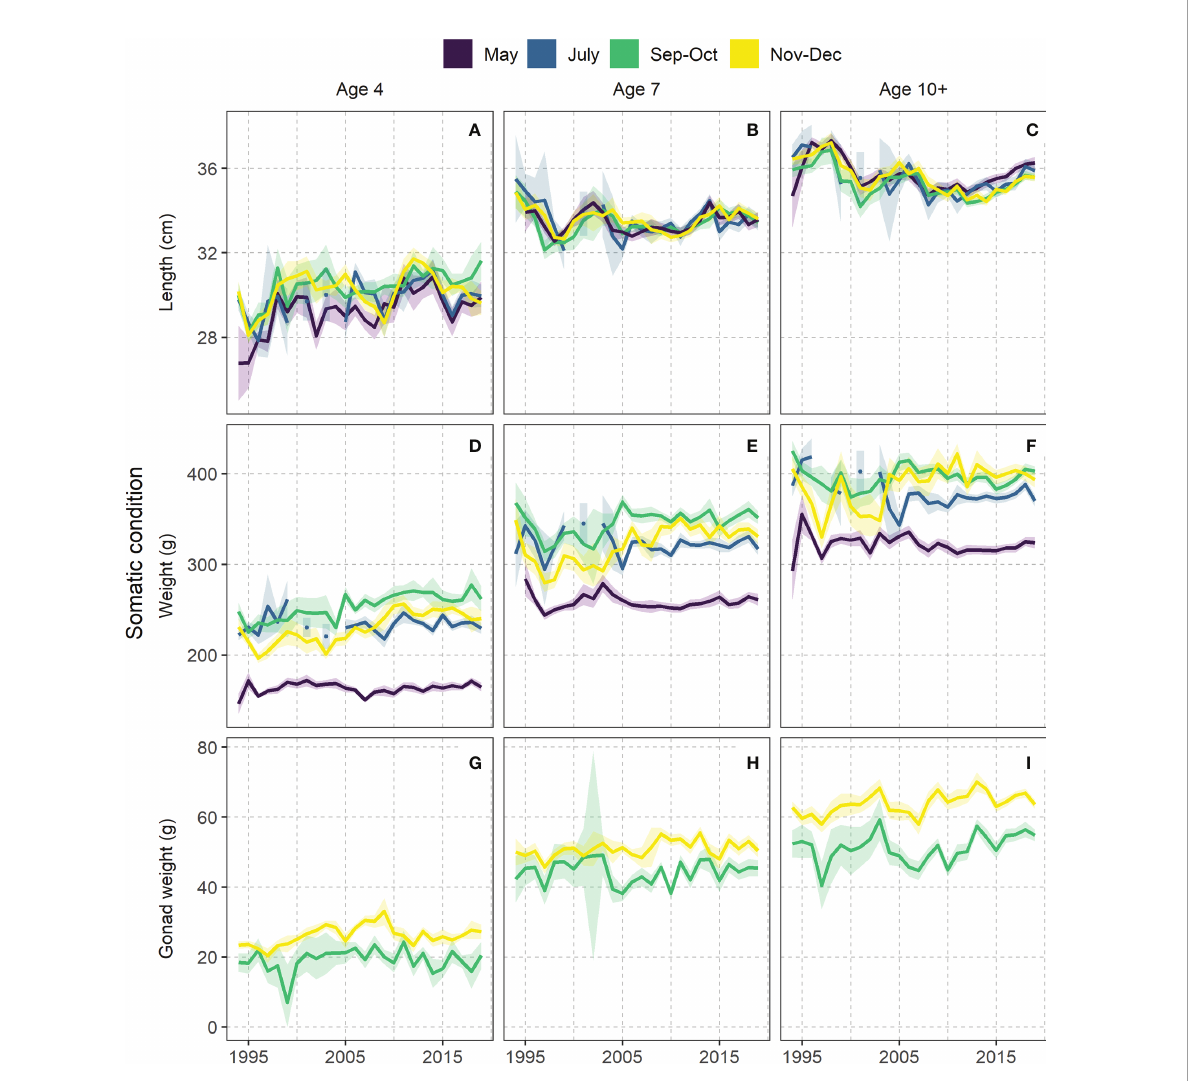
FIGURE 5 Marginal effects of sampling year and season on length at age (A – C) , somatic condition (D – F) and gonad development (G – I) from the spatiotemporal model. Presented for ages 4, 7 and 10+ (age 10 and older). All covariates except year were fi xed at their median observed values and spatial effect set to zero. For detailed depictions including all ages, see Figure